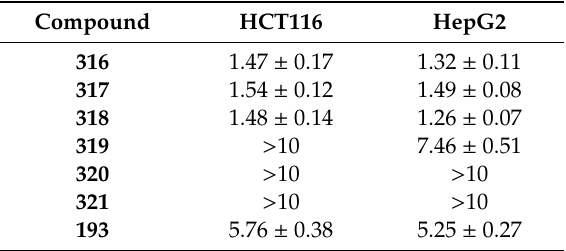
Table 37. In vitro cytotoxic e ff ects of compounds 316 – 321 against human colon carcinoma cells